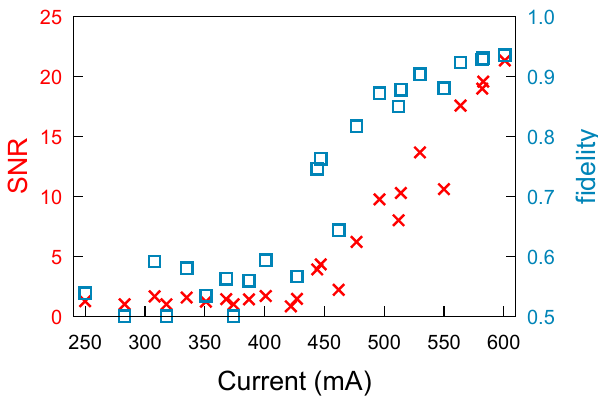
Figure 5. Signal-to-noise ratio and fidelity to a Bell state as a function of the current for one of our devices.